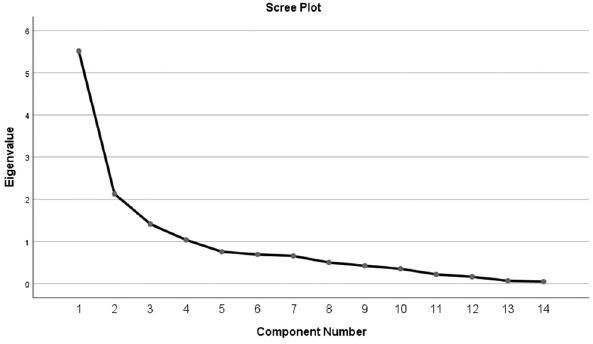
Figure 1: Scree plot showing contributions of PCs to variability.